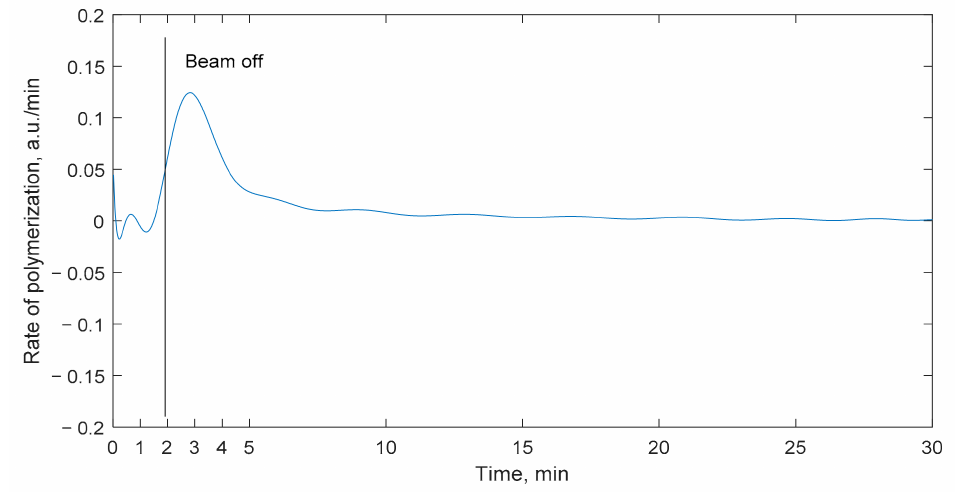
Figure 6. Temporal changes of polymerization rate through time for nMAG gel